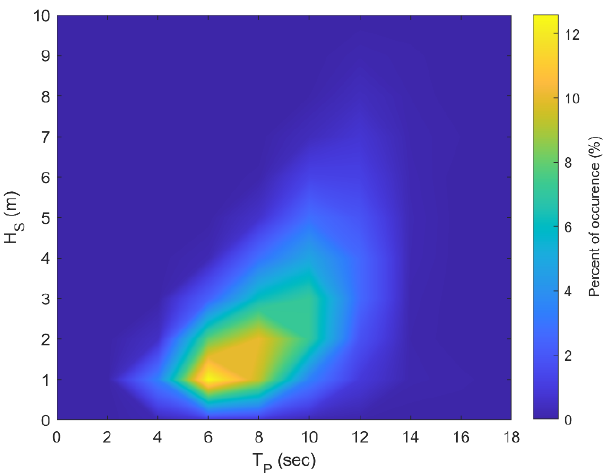
Figure 6. Scatter diagram of the northern route from the British Channel to the east coast of the USA [58].